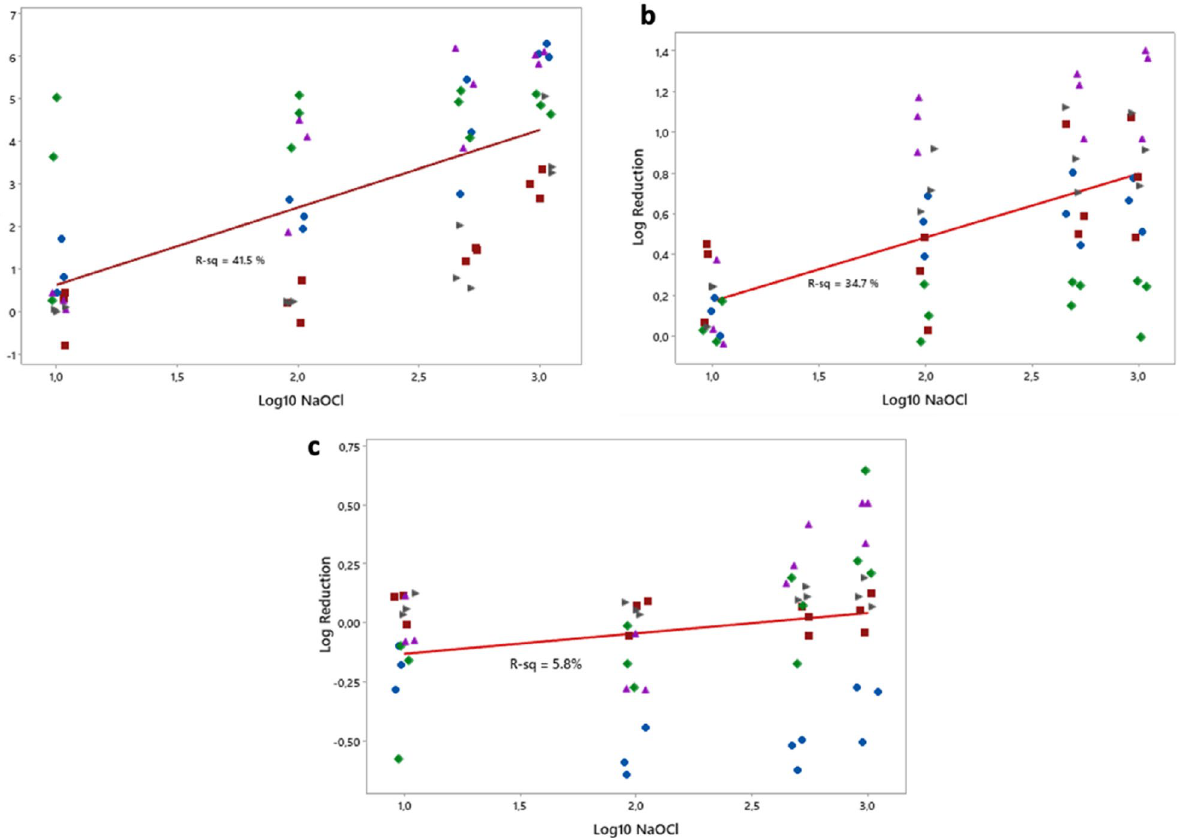
Figure 2. Dose response curves for treatment data. Each data point represents the mean LR per experimental day, per lab. The red curve indicates the regression line. ( A ) Plate count, ( B ) Resazurin, ( C ) Crystal violet.